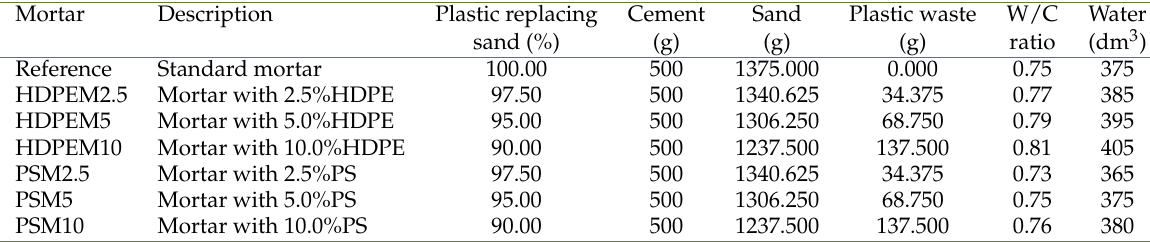
water requirement was recorded in terms of W/C